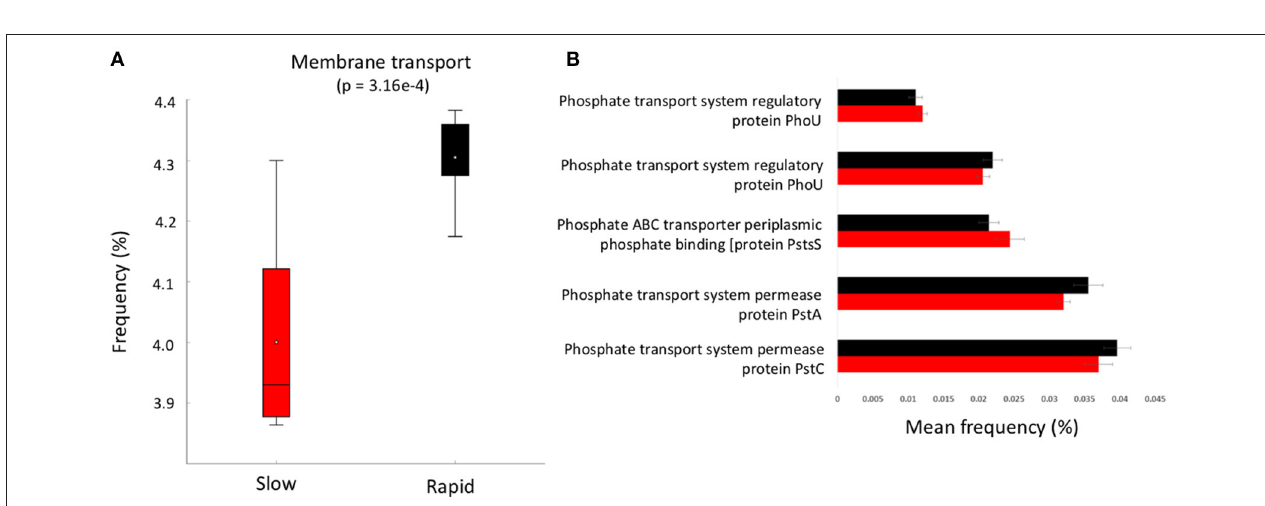
FIGURE 4 | (A) boxplot of metabolic function abundance for membrane transport and (B) abundance of phosphorus transport pathways ( > 0.01% abundance, t -test of differences in abundance p < 0.05). Error bars = SD and red represents slow degrading cluster, black represents rapid degrading cluster.